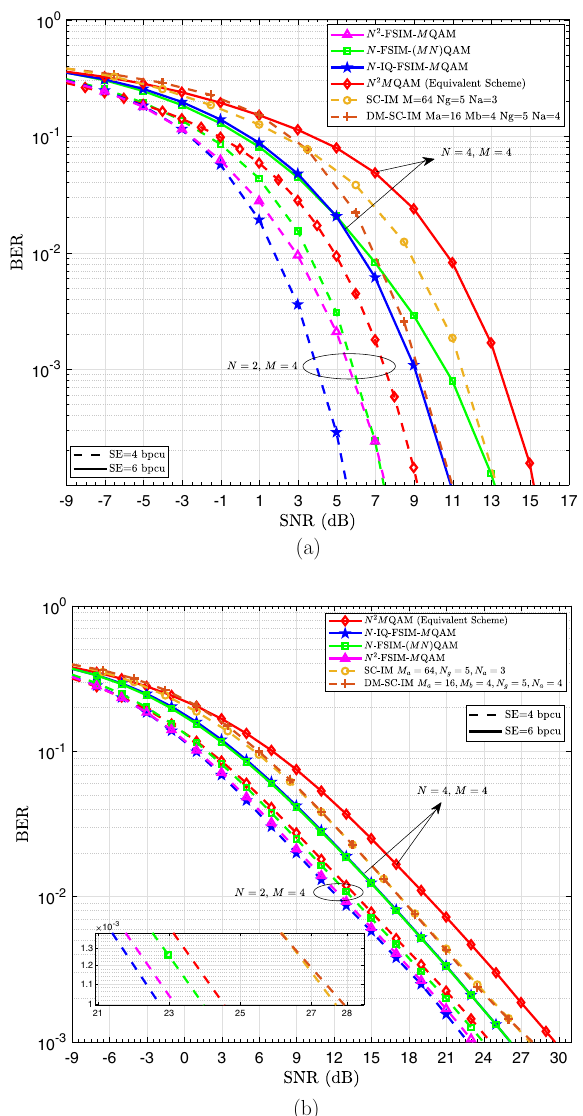
Fig. 13 BER performance for IQ-FSIM and different equivalent systems of similar SE (4 and 6 bpcu) in: a AWGN channel, b flat Rayleigh fading channel ( J = 1